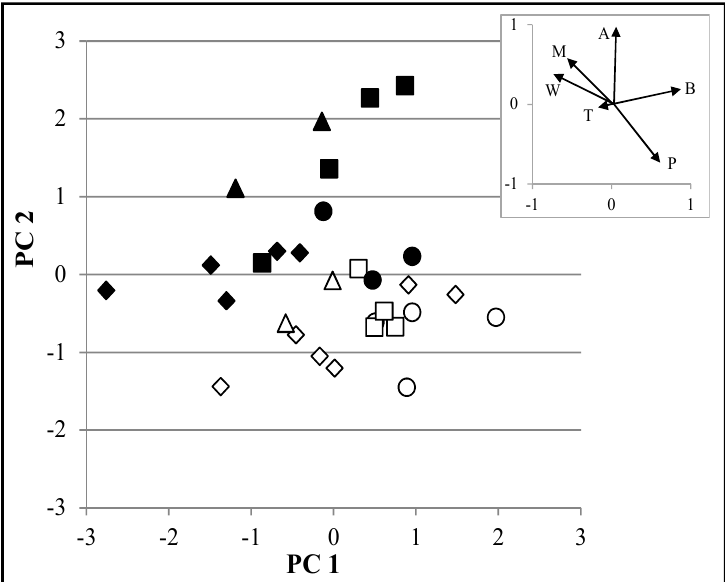
Figure 5. Distribution of the vineyards based on the PCA of must composition at harvest, with group discrimination by season: 2012 (∆ E SE ○ SW □ W); 2013 ( ▲ E SE ● SW ■ W ). In the small box the values of the eigenvectors of the six variables included in the model are shown: W = berry weight, B = total soluble solids, T = titratable acidity, p = pH, M = malic acid, A = anthocyanins.